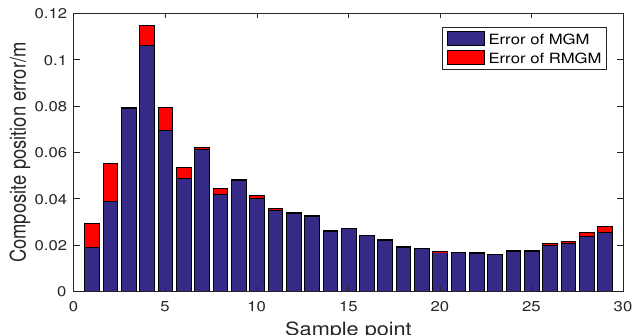
Figure 18. Combined position errors of MGM and RMGM.